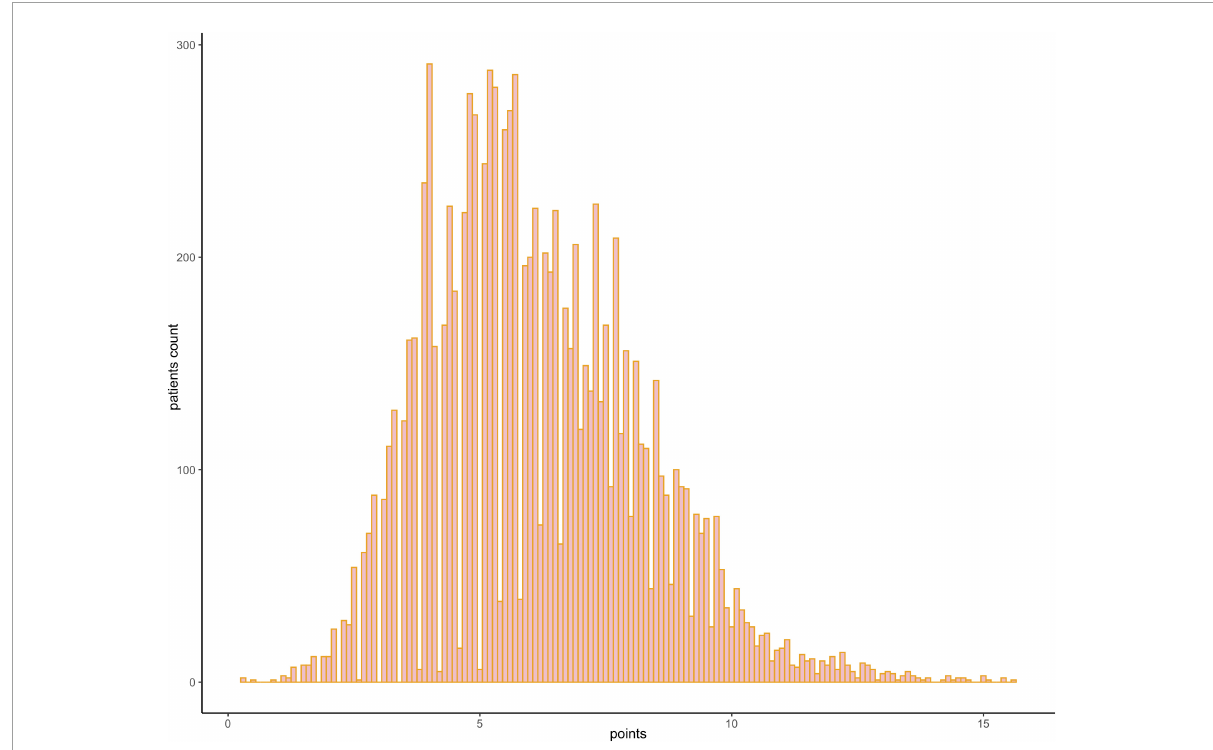
FIGURE4 Frequency distribution bar graph of the cohort. The distribution of the risk scores of the population.